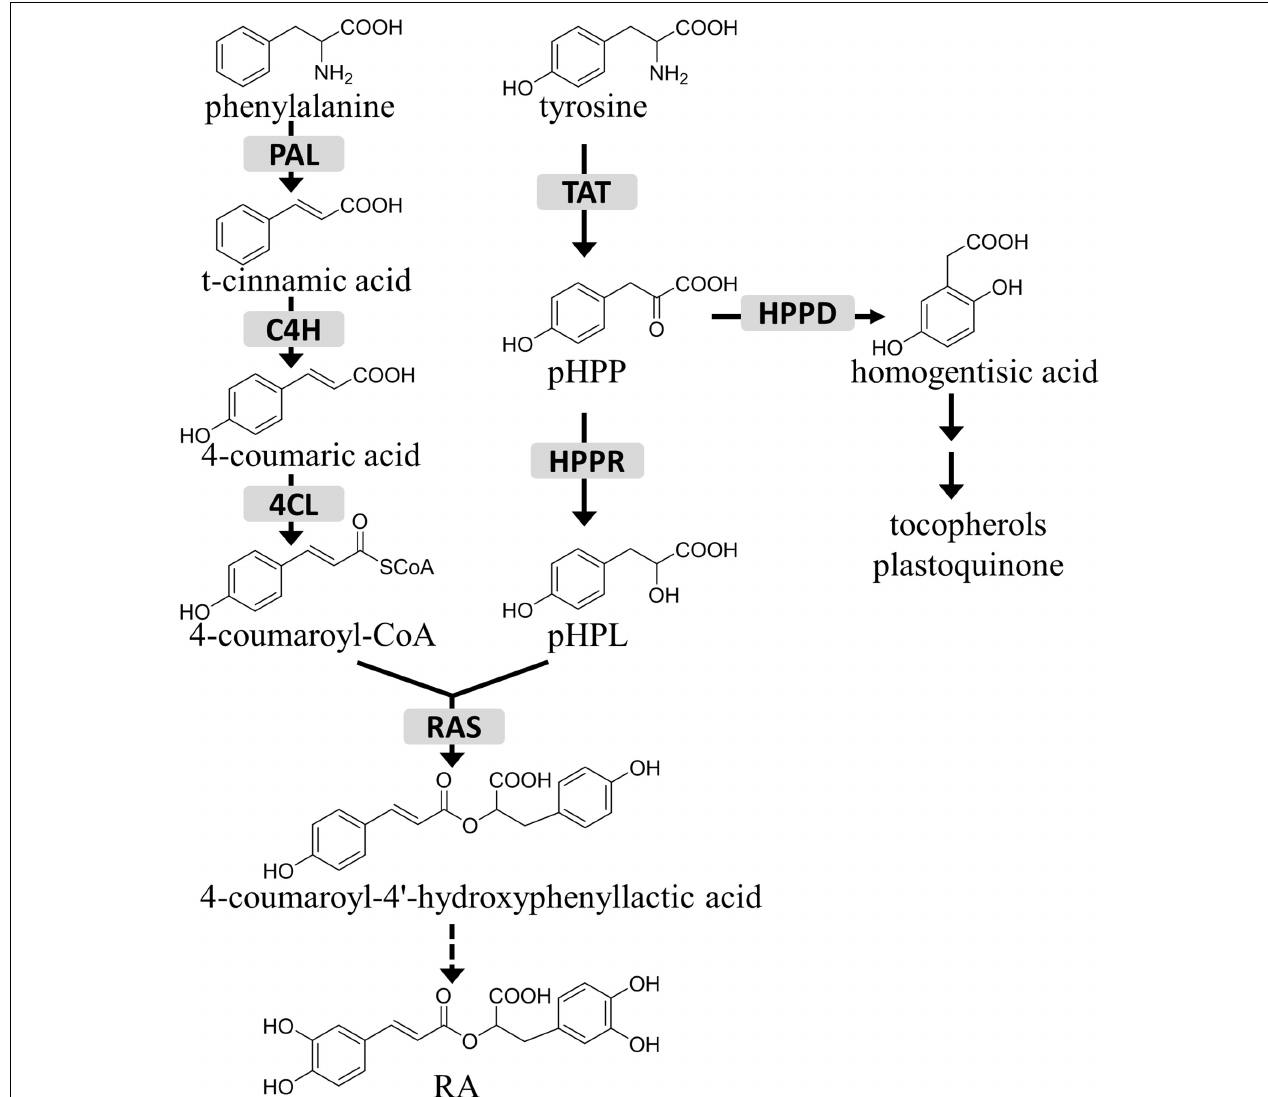
FIGURE 1 | The role of HPPR in the tyrosine conversion pathway. TAT, tyrosine aminotransferase; HPPR, hydroxyphenylpyruvate reductase; HPPD, 4-hydroxyphenylpyruvate dioxygenase; RAS, rosmarinic acid synthase; PAL, phenylalanine ammonia-lyase; C4H, cinnamic acid 4-hydroxylase; 4CL, 4-coumaric acid CoA-ligase; pHPP, 4-hydroxyphenylpyruvic acid; pHPL, 4-hydroxyphenyllactic acid; RA, rosmarinic